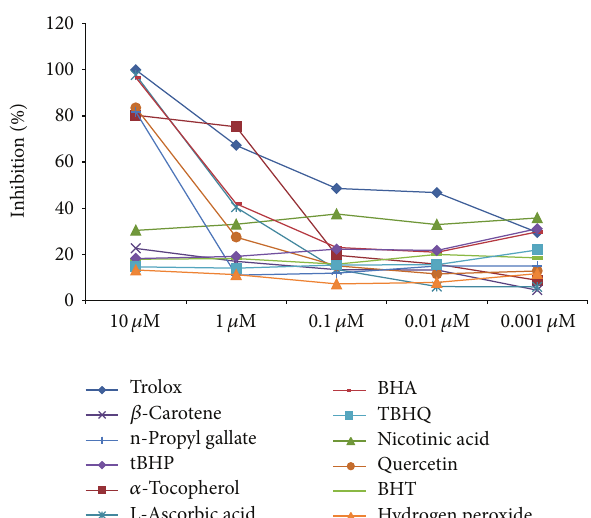
Figure 5: Percent slope (rate) of the time-dependent kinetics with respect to control.